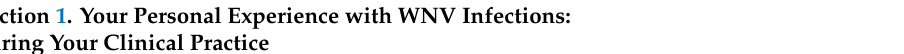
Table A1. Authors’ translation of the items included in the